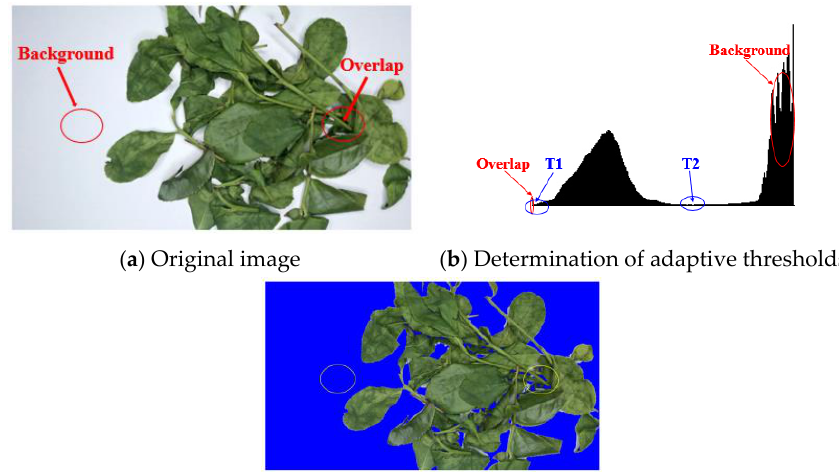
Figure 4. Adaptive dynamic energy filtering.